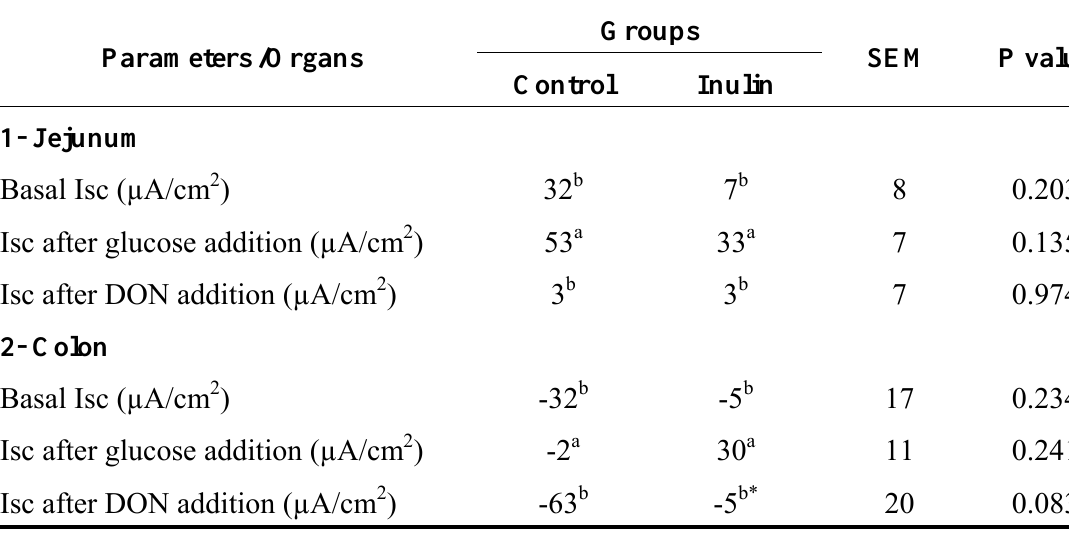
Table 2 . The short-circuit current (Isc) in isolated jejunal and colonic mucosa of broilers after addition of glucose and DON.